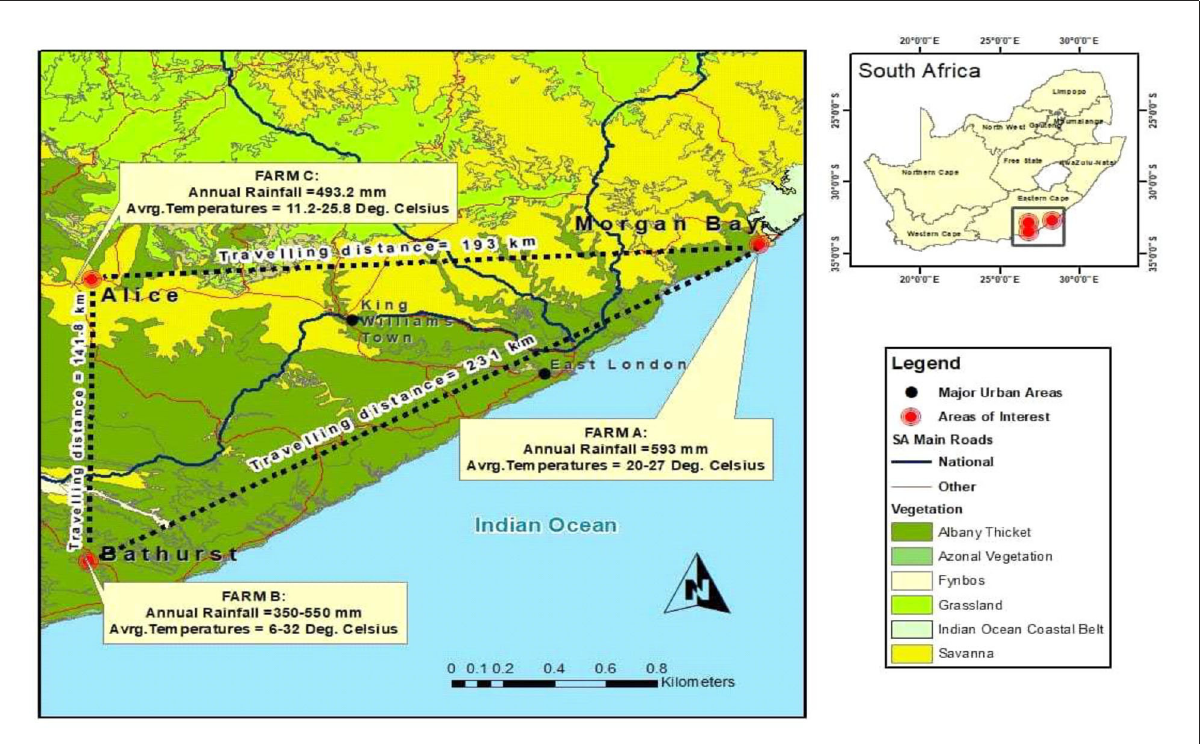
FIGURE1 Geographic location of the three farms that participated in the current